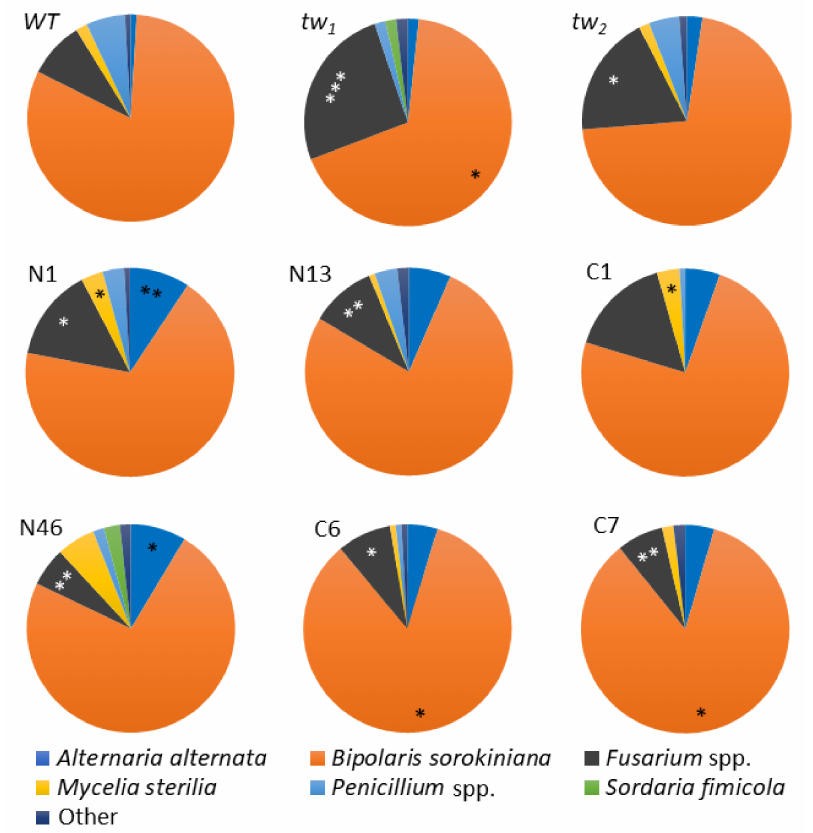
Figure 4. Spectra of fungi (%) in the internal grain tissues of barley tw mutants and the WT . The middle row—revertants from tw 1 ; the lower row—revertants from tw 2 . N—revertants with normal spike and floral structure, C—revertants with normal floral structure but compactoid spikes. Grain was produced in 2013, and the analysis was performed in 2014. The asterisks represent significant differences (* p < 0.05; ** p < 0.01; *** p < 0.001) between the tw -type mutant and the WT (in the upper row) or between the revertant and the respective initial tw mutant (N1, N13 and C1 derived from tw 1 , N46, C6 and C7—from tw 2